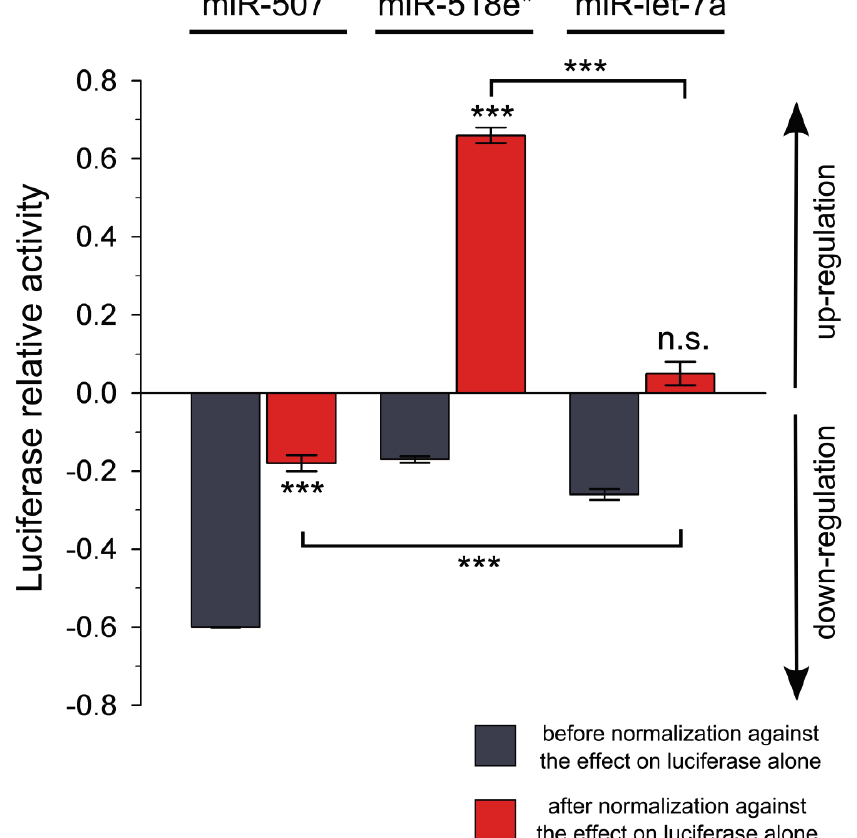
NEFL 3'UTR. Data from reporter assays before (gray) and after the normalization (red) against the effect of the miRNAs on the Firefly luciferase reporter alone are shown.